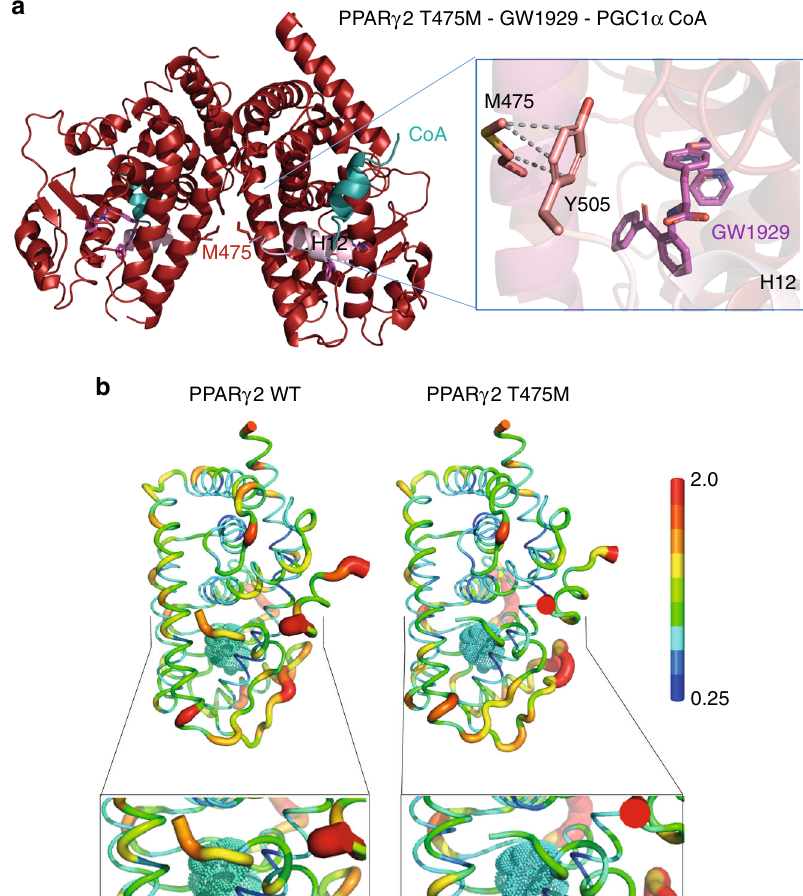
Fig. 4 Structural properties of PPAR γ T475M. a Crystal structure of the PPAR γ T475M LBD (red) in complex with GW1929 (violet) and the PGC1 α coactivator peptide (blue). The C-terminal H12 helices are shown in light pink. Overall fold of the homodimer complex, showing the T475M mutations at the dimer interface as a stick representation. Right: Close-up of the regions around the mutation, showing its interactions with the terminal Y505 residue responsible for stabilizing the agonist conformation. b The PPAR γ T475M mutation modulates the structural dynamics of the LDB. Mean structure and atomic fl uctuations of the holo PPAR γ WT LBD-coactivator (left) and holo PPAR γ T475M LBD-coactivator (right) complexes, with the rosiglitazone ligand (in cyan), and the scale of fl exibility shown. Bottom: Close-up of the C-terminal H12 helix of the WT and mutant LBDs, as determined from